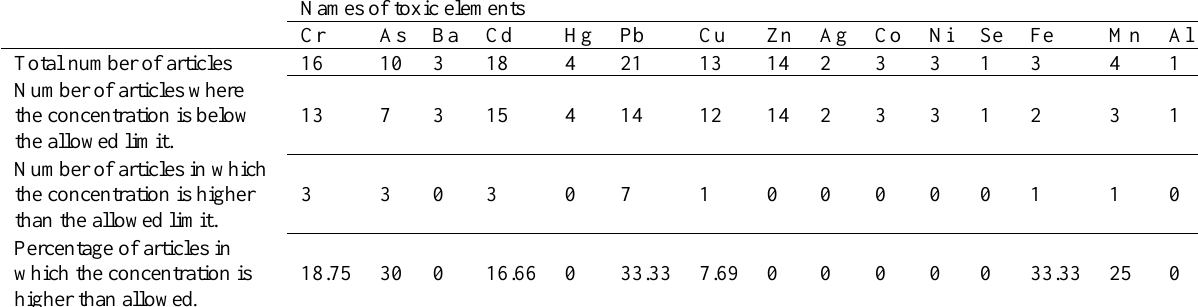
Table 3. Statistics of different types of toxic elements examined in the articles Names of toxic